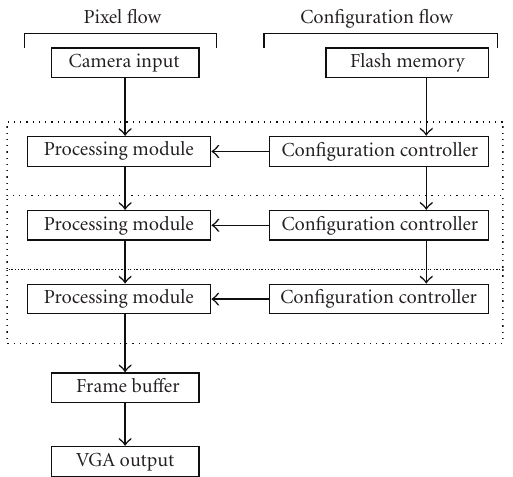
Figure 1: Integration of an array of 3 processing modules in the experimental context.